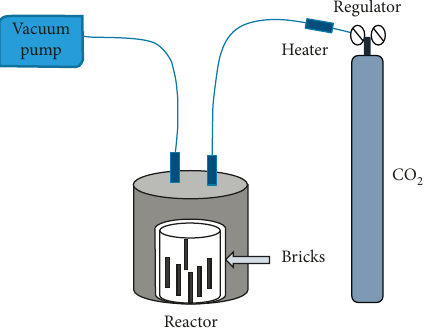
Figure 2: Schematic graphic expression of the mineralization